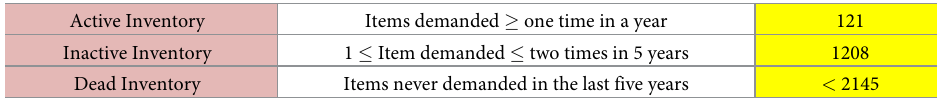
Table 3. Retaining stock segregation based on analysis of historical